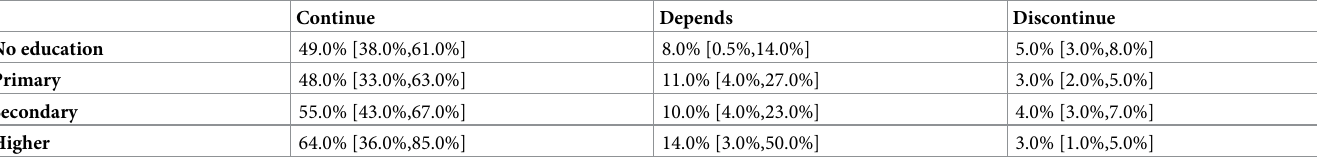
Table 3. Values for Fig